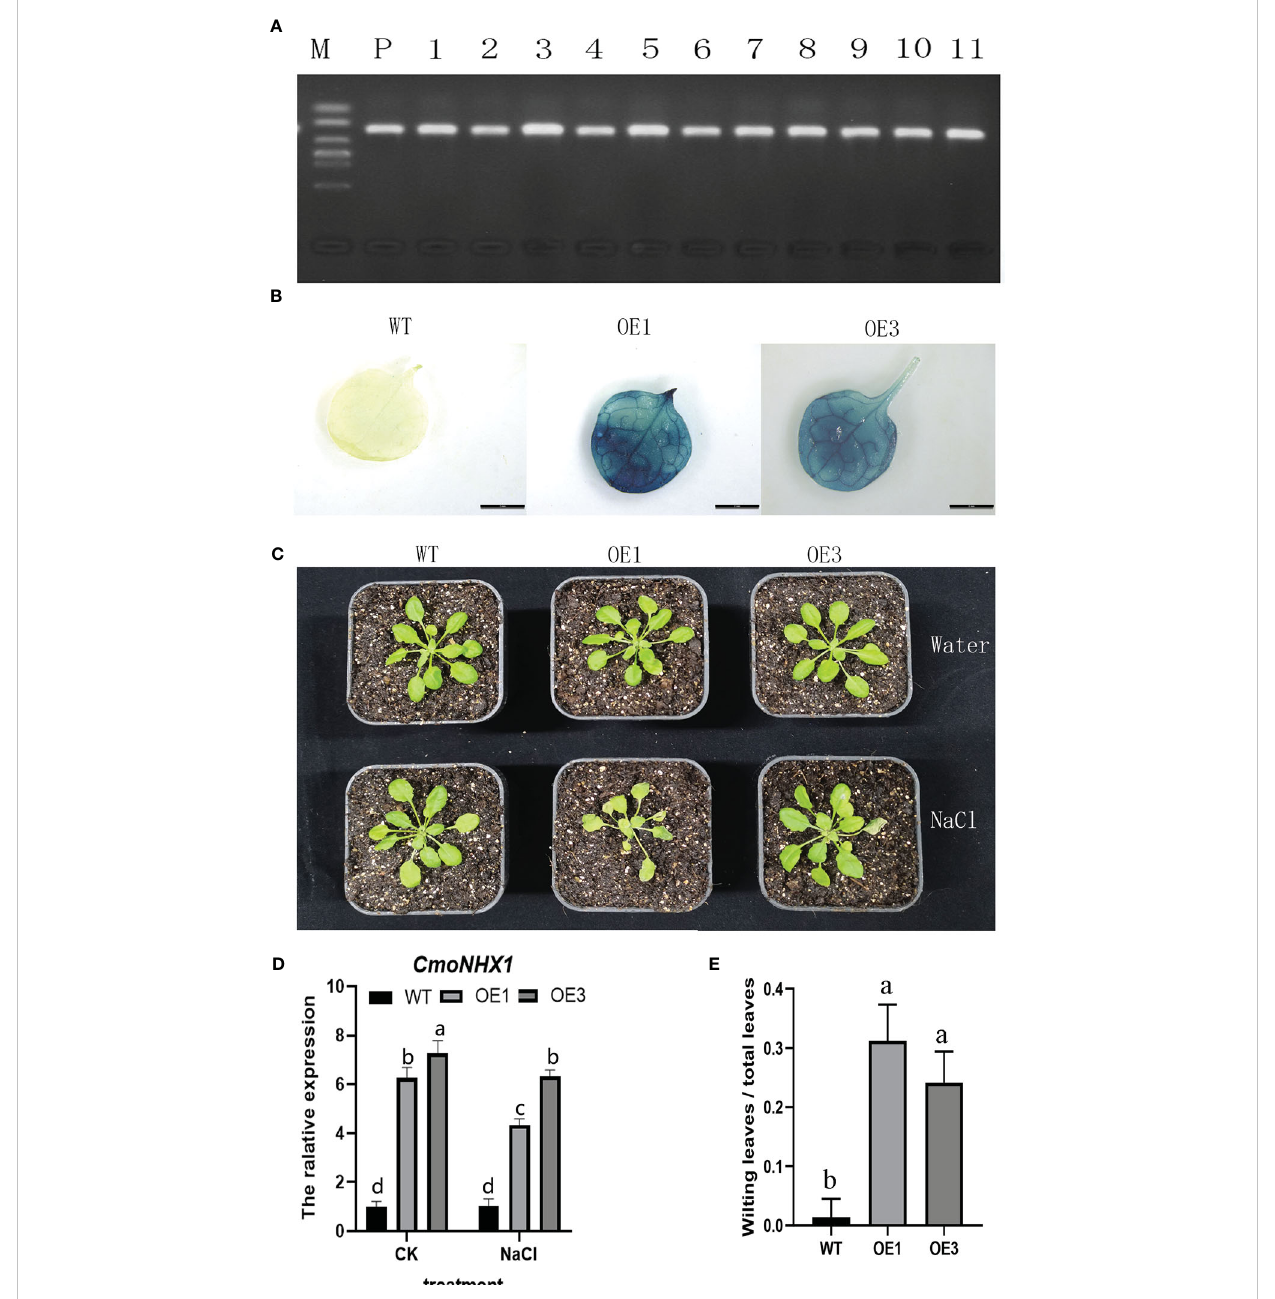
FIGURE 8 Positive identi fi cation and phenotype analysis of CmoNHX1 -heterologously expressed A. thaliana plants. (A) , Identi fi cation of hygromycin resistance genes; (B) , GUS staining veri fi cation; (C) , Analysis of plant phenotype characteristics; (D) , Relative expression quantity of CmoNHX1 in transgenic and wild-type plants; (E) , The ratio of wilting leaves to total leaves under salt stress. For the wild type, OE1 and OE3 plants, 8 plants were selected respectively for statistics. The data were represented as the means of three replicates, and error bars represented the standard deviations of means. Different letters above the bars indicated signi fi cant differences ( p < 0.05) between